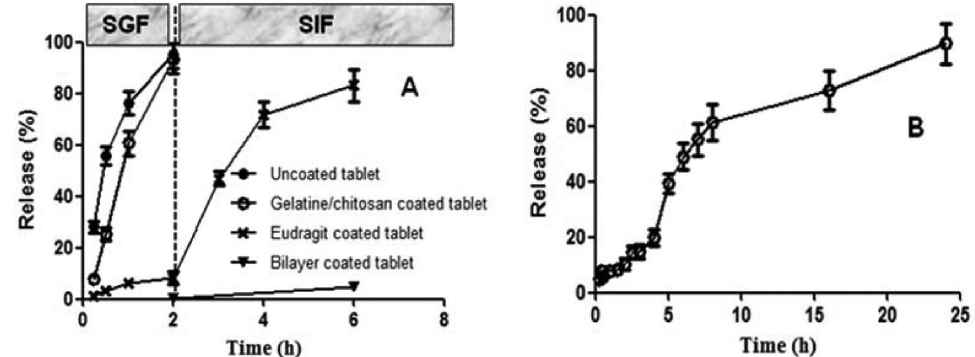
FIGURE 6 - Dissolution profiles of uncoated tablet and gelatin/chitosan, Eudragit and bilayer-coated tablets in SGF and SIF (A), and bilayer-coated tablet in SCF after it was tested in SGF for 2 h and SIF for 4 h (B). TABLE IV - Physicochemical properties of bilayer‑coated tablet during 6‑month accelerated stability studies Time